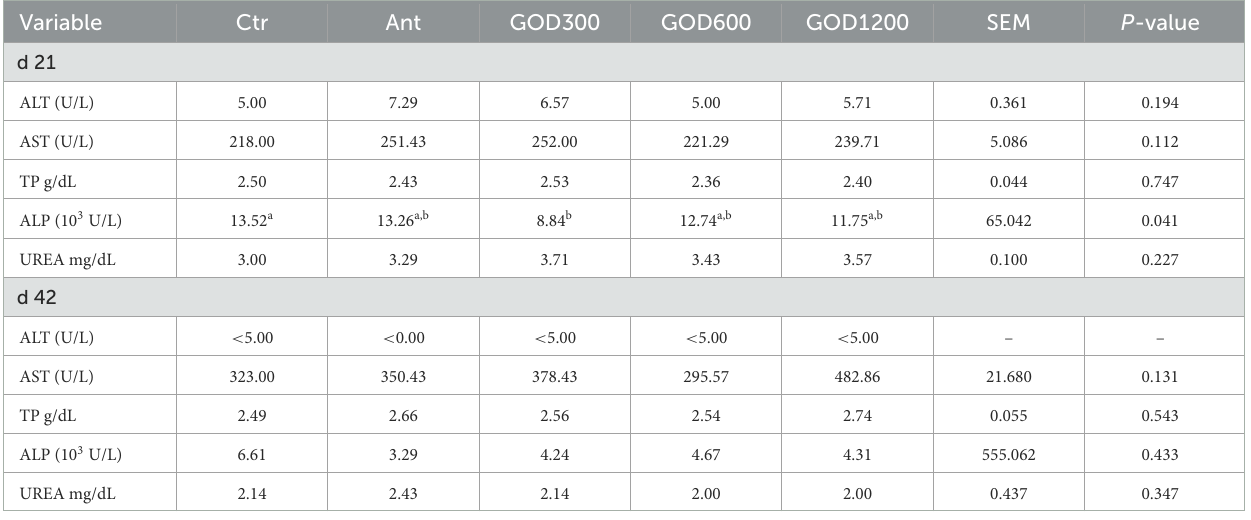
TABLE 5 Effect of GOD on the biochemical parameters of broilers in serum (mean ± SEM, n = 6).